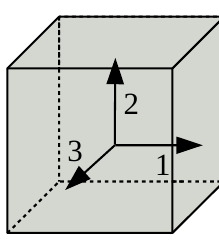
Figure 3. Coordinate